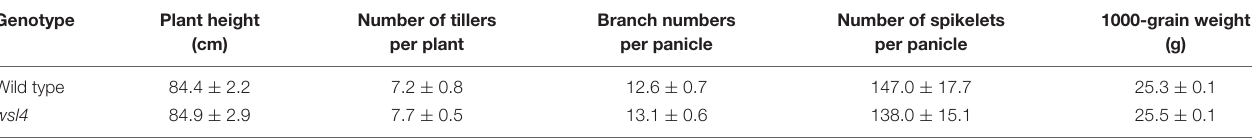
TABLE 1 | Statistical analyses of major agronomic traits between WT and the wsl4 mutant.